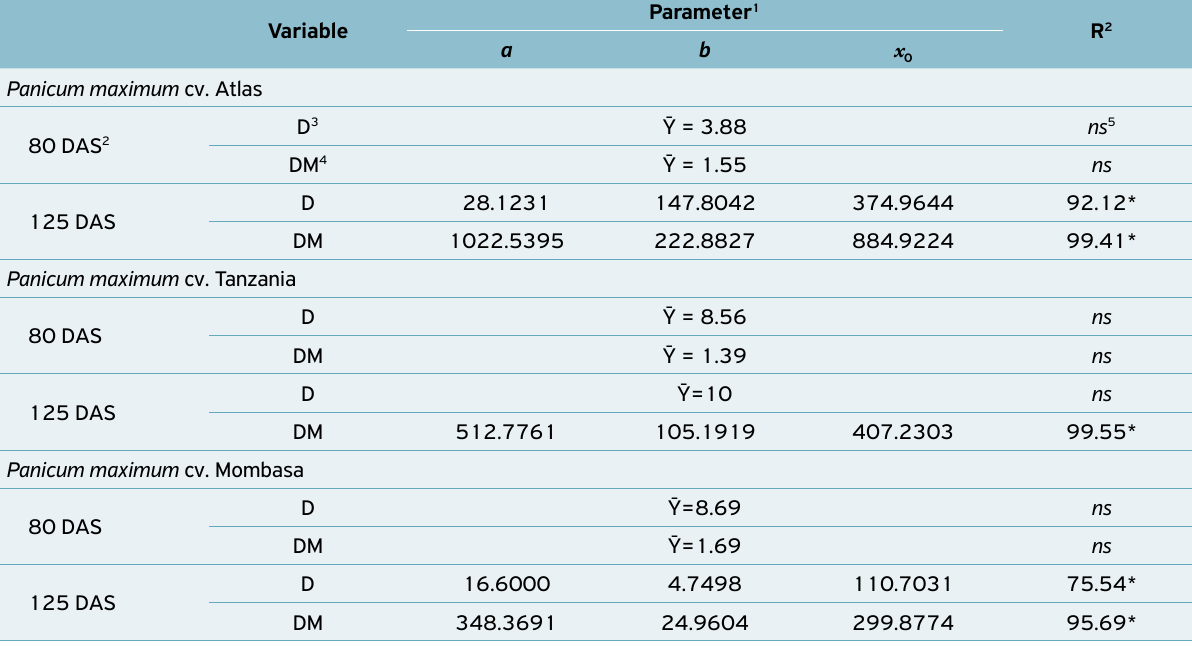
Table 4. Parameters of the regression equations obtained by fitting the sigmoidal model and coefficient of determination (R 2 ) applied to the means of weed density (plants m -2 ) and weed dry matter (g m -2 ) in the cultivation of Panicum maximum cv. Atlas, P. maximum cv. Tanzania, and P. maximum cv. Mombasa at 80 and 125 days after sowing as a function of glyphosate doses (0, 54, 108, 270, 378, 540, 756, and 1,080 g a.e. ha -1 ) associated with atrazine (1,200 g a.i. ha -1 ).